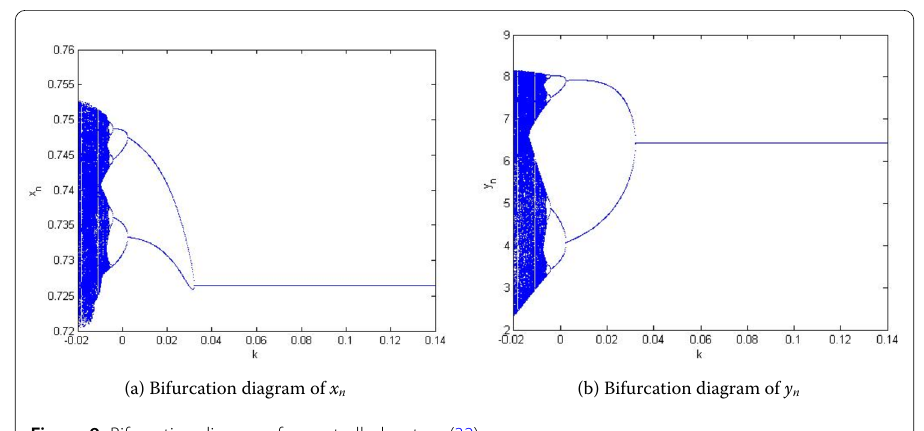
Figure 9 Bifurcation diagrams for controlled system